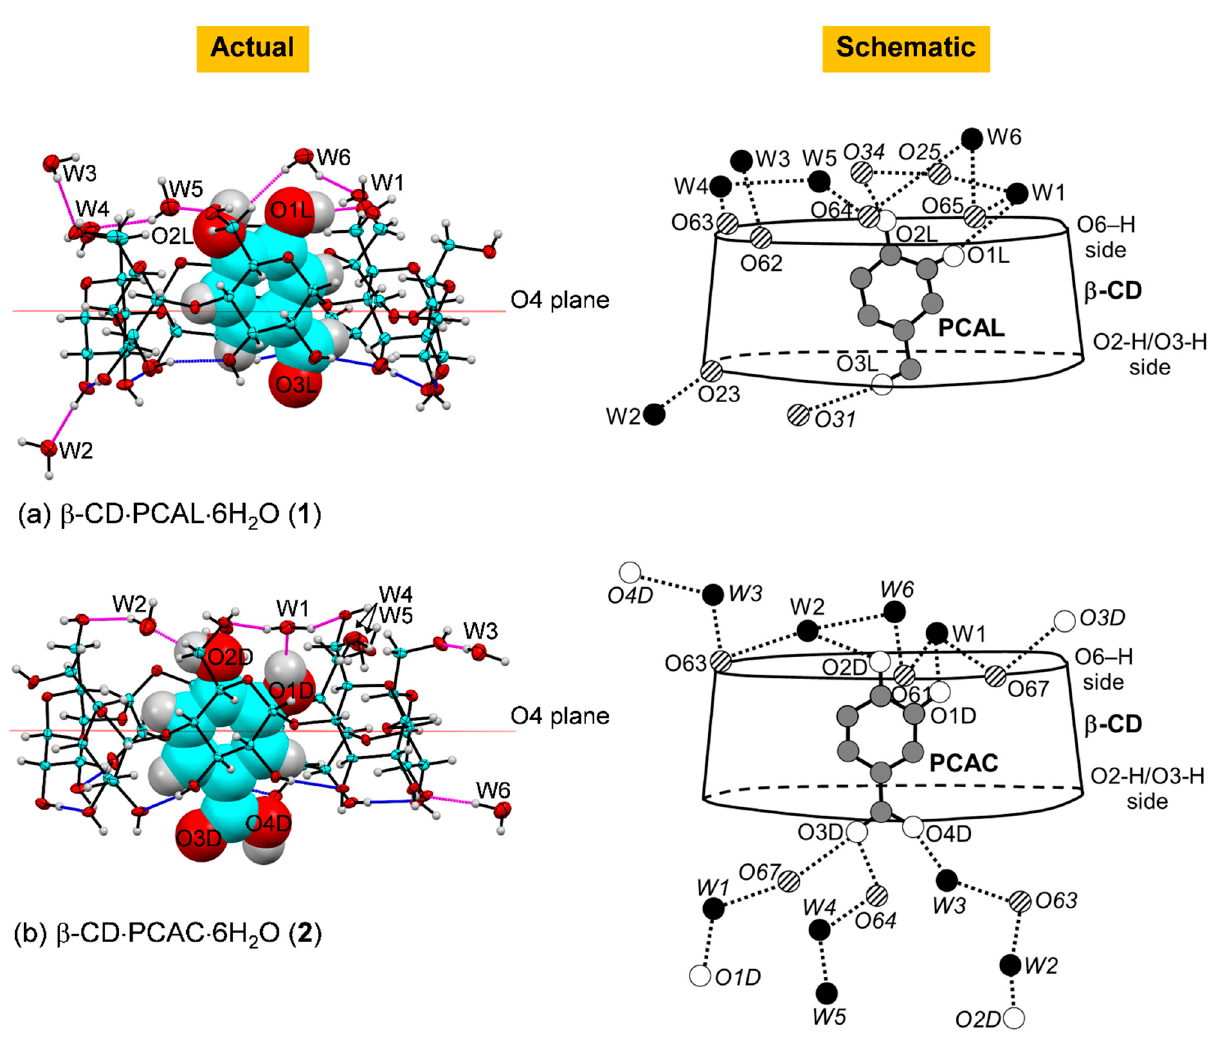
Figure 4. Actual and schematic diagrams depicting inclusion geometries and hydrogen bonding of the complexes ( a ) β -CD–PCAL ( 1 ) and ( b ) β -CD–PCAC ( 2 ) in the solid state at 296 K; ORTEP plot at 30% probability level. In actual diagram presenting the asymmetric unit, O–H ⋯ O hydrogen bonds within β -CD and between other molecules are shown with blue and magenta connecting lines; respectively. In schematic diagram, O–H ⋯ O hydrogen bonds are shown with dotted lines; names in italics indicate molecules / groups of the adjacent asymmetric units; see also Figure 5 and Table 2 .